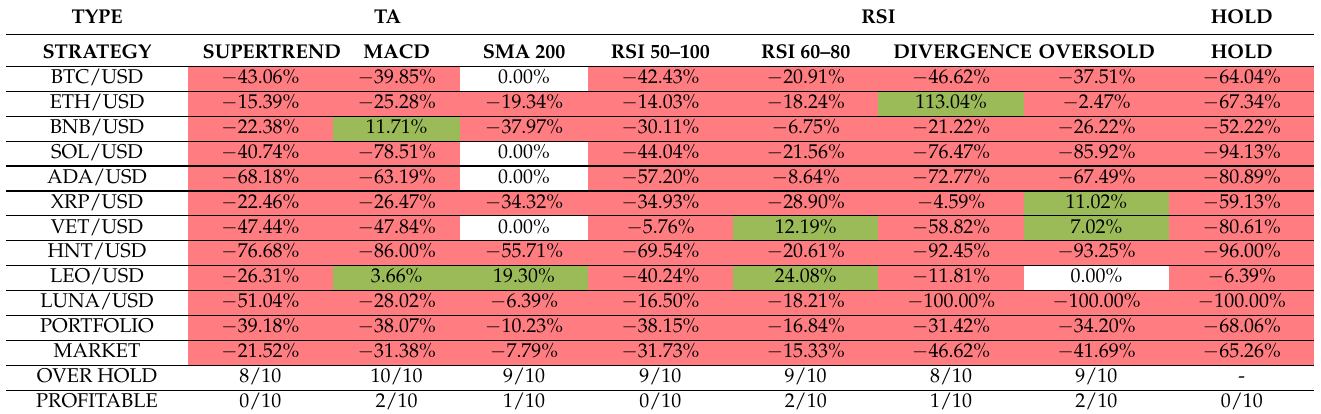
Table 11. The results of strategies from experiments compared to popular trading strategies and strategy proposed by authors between 2022 and 2023 on a new portfolio. Green indicates positive results, red indicates negative